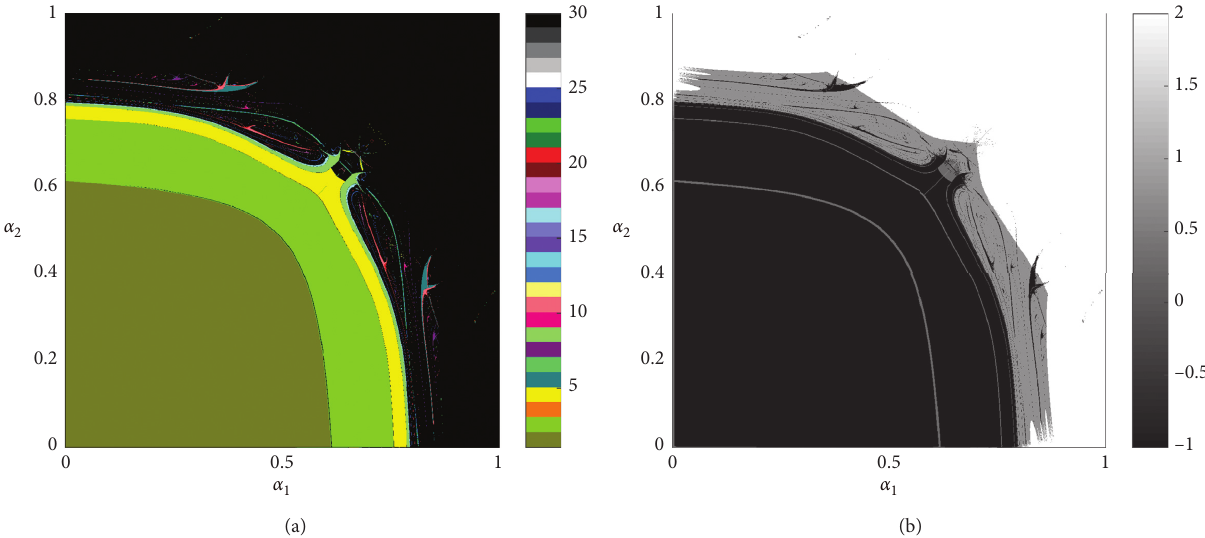
Figure 1: (a) The two-dimensional bifurcation with respect to ( α corresponding to Figure